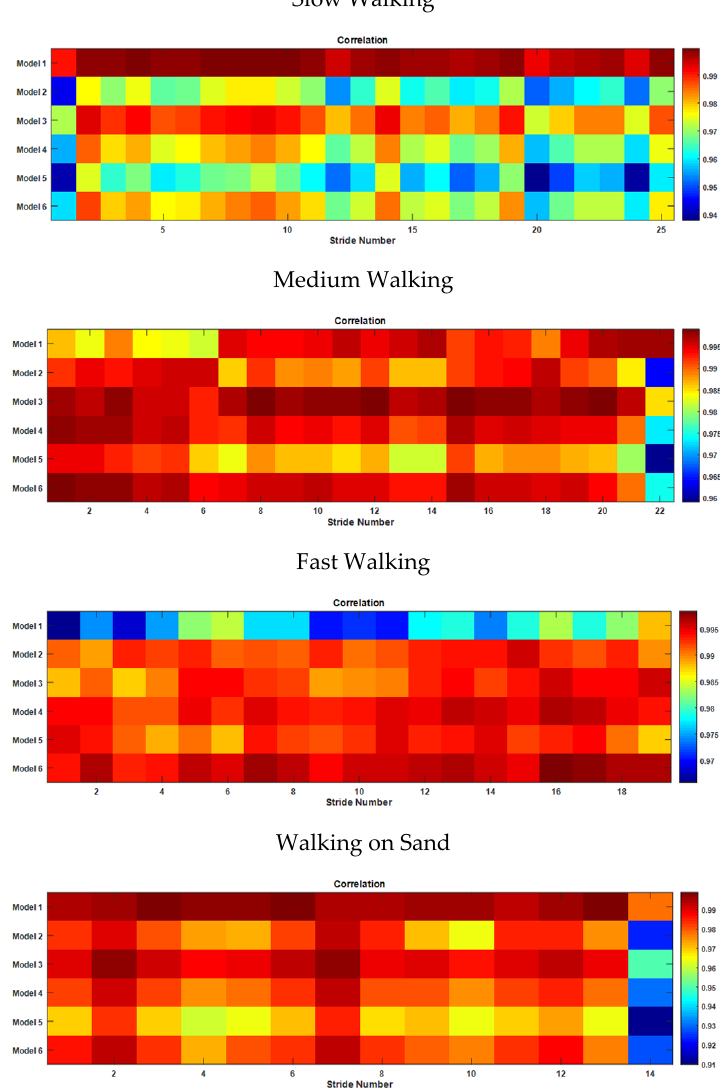
Figure 16. Correlation of each stride with model-generated waveform for different cases.